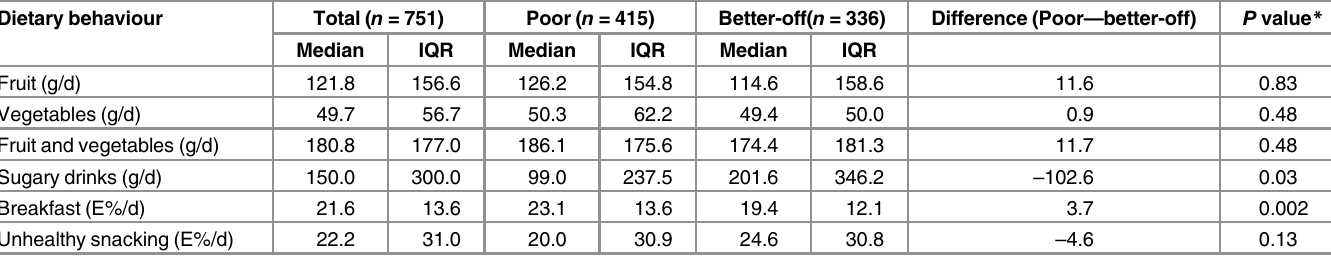
Table 2. Key components of dietary behaviour as measured by two 24h dietary recalls. Dietary